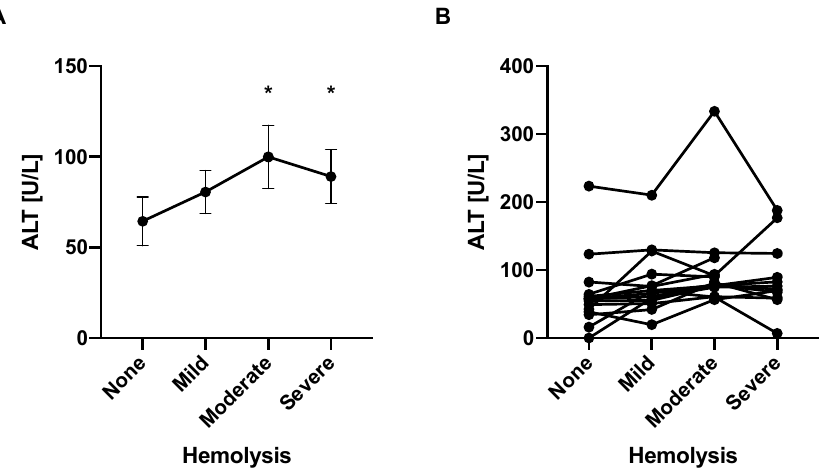
Figure 4. Higher degree of hemolysis is associated with higher ALT levels. Blood samples from mice ( n = 15) were obtained with EDTA (“EDTA-treated plasma”). Hemolysis was induced for a portion of each volume by use of a microbeads beater and groups of varying degrees of hemolysis were created by mixing volumes of non-hemolyzed and hemolyzed amounts of each sample, as described